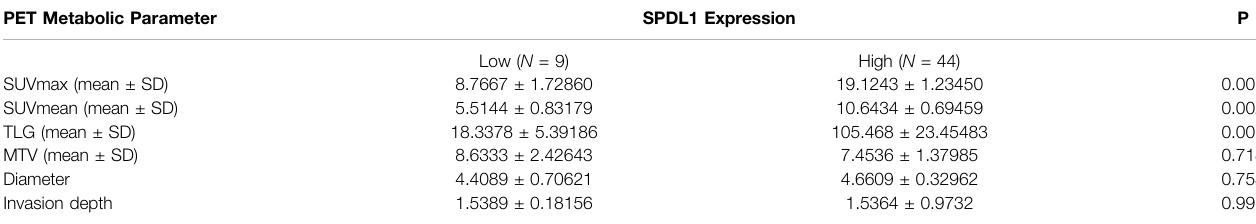
TABLE 2 | SPDL1 overexpression was associated with 18F-FDG PET/CT metabolic parameters of ESCA patients. PET Metabolic Parameter